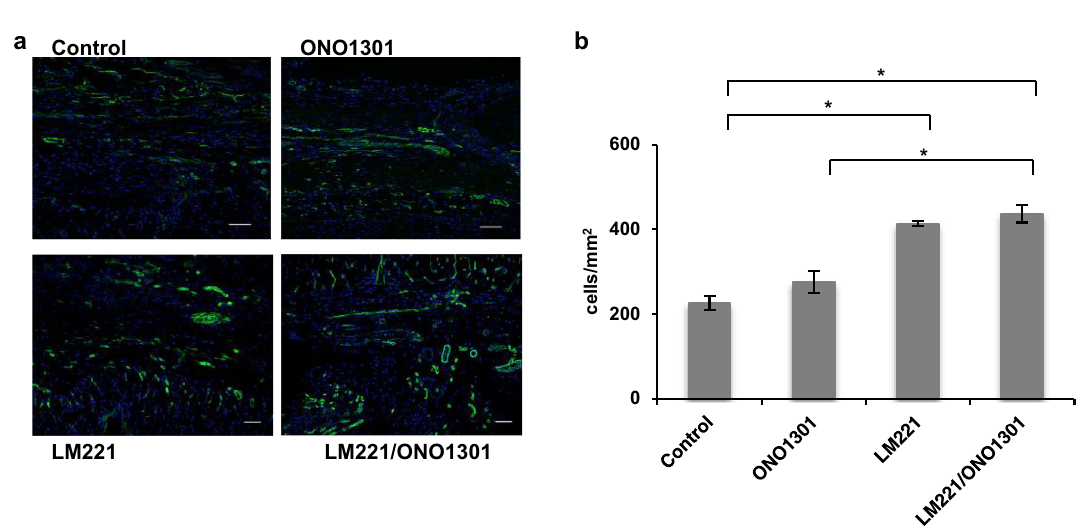
Figure 4. Combined administration of LM221 and ONO1301 increased ILB4-positive cells. The number of ILB4-positive cells in the implanted site increased following combined administration of LM221 and ONO1301, as observed by immunohistochemical analysis. Representative microscopic images show ILB4 (green) and nuclei (blue). Scale bar = 50 μm. The graph indicates the number of ILB4-positive cells at the implanted site. * p <